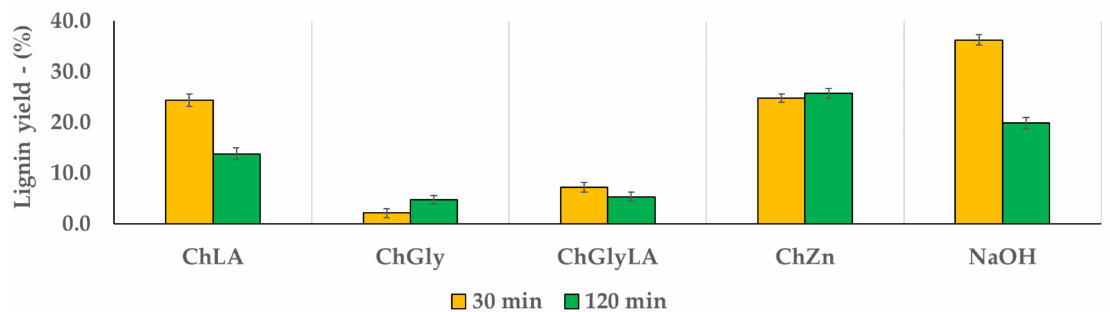
Figure 3. Lignin precipitations yield for different NaDES, according to process time. NaOH 10% is reported as a benchmark.